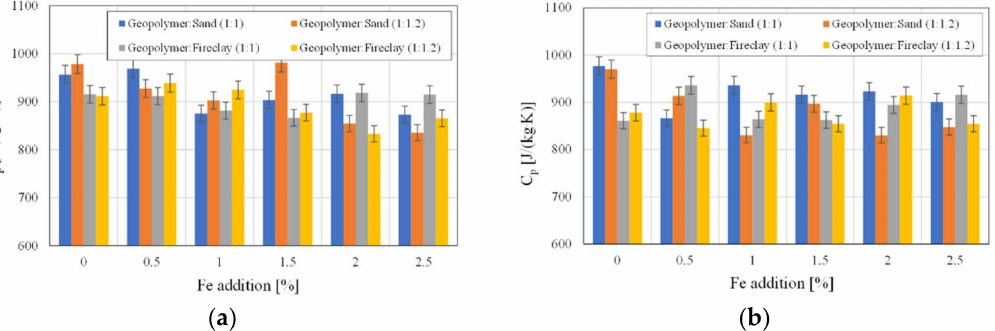
Figure 8. The values of specific heat C p with regard to the used aggregates and the amount of added Fe: ( a ) before drying, ( b ) after